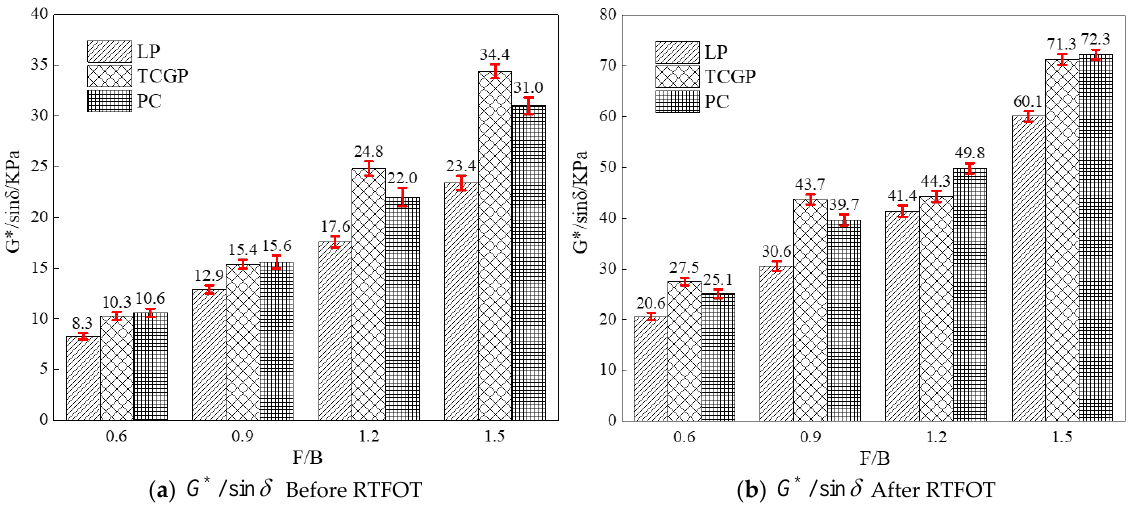
Figure 6. Effect of filler type and F/B on * / sin G of emulsified asphalt mastics (58 ℃ ).